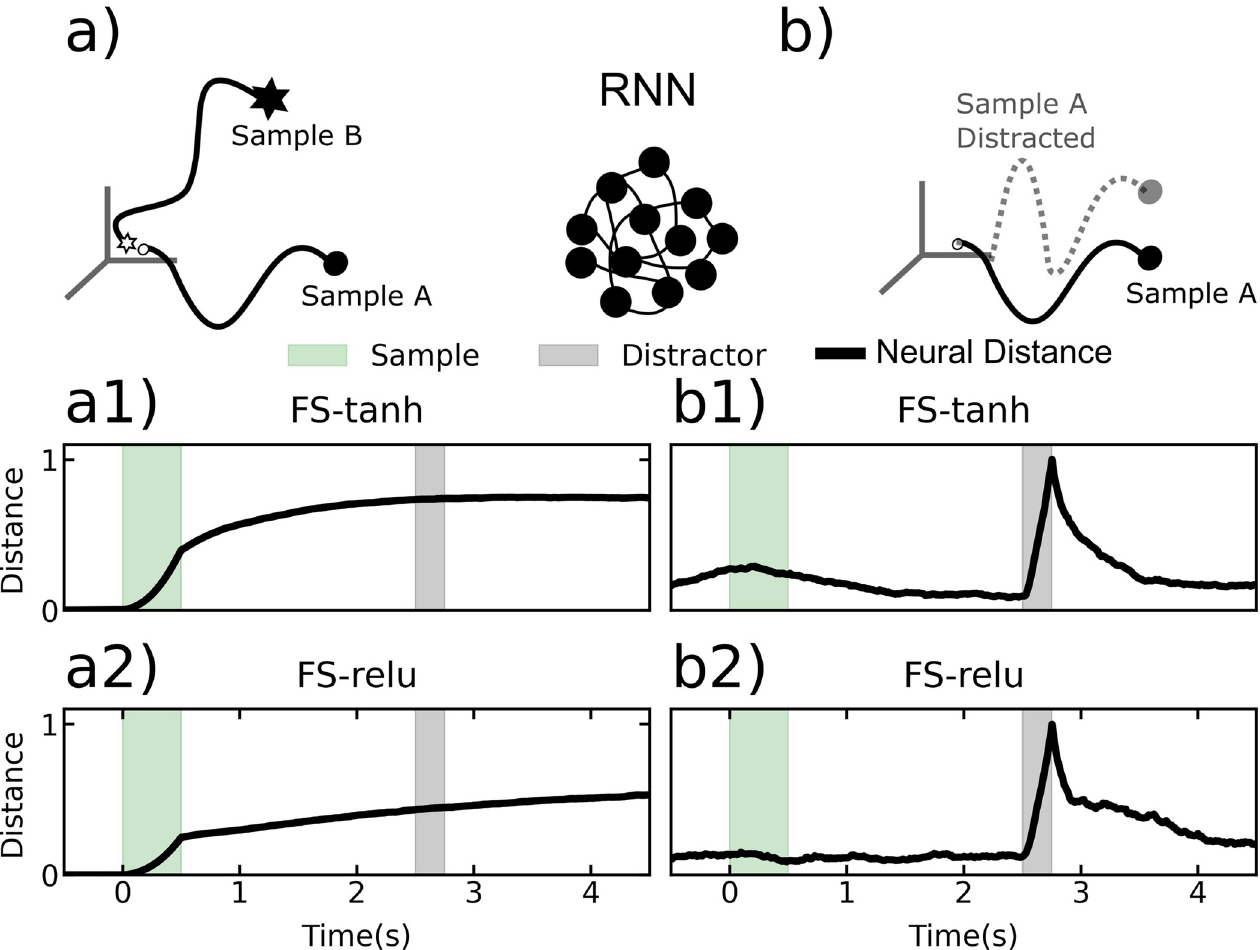
Fig 7. Distances between neural trajectories within a sample condition and between sample conditions, for fixed synapse RNNs. All models used were the most ‘brain-like’, as determined by the methodology in section “RNNs With STSP are More Brain-Like”. a) Cartoon of trial-averaged RNN trajectories corresponding to two different sample conditions for the fixed-synapse RNNs. a1) Average pairwise distance between trajectories on different sample conditions, for the fixed synapse network with tanh activation (FS-tanh). a2) The same plot as in a1, but for FS-relu. b1) The average distance between distracted and undistracted trajectories. Average taken over all sample conditions. Results shown for FS-tanh. b2) Same results as in b1, but for FS-relu.